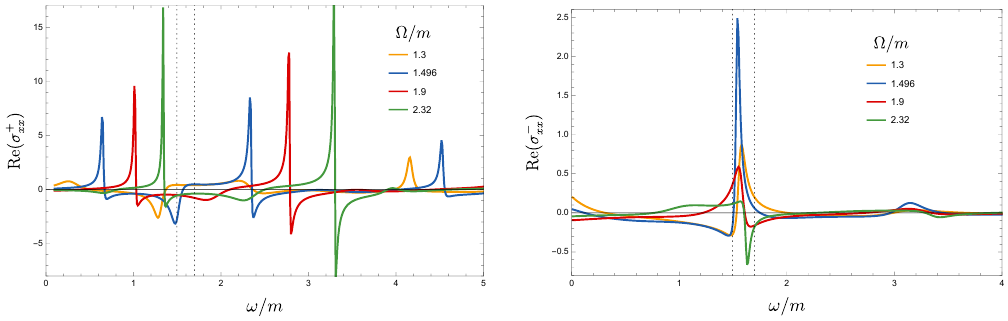
Figure 18 . Peaks in the AC conductivities along the critical line to the right of the (cid:12)rst Floquet condensate (see (cid:12)gure 12). The vertical dashed lines signal the critical Floquet and the meson mass frequencies respectively. The central peaks bunch in this region whereas the two lateral peaks move with ! while keeping their inter-spacing almost constant.